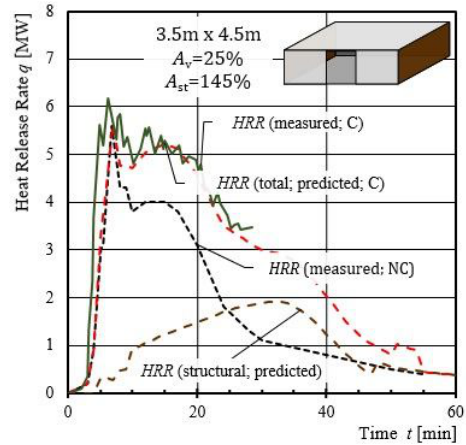
Figure 20: Predicted and measured HRR for experiment V.